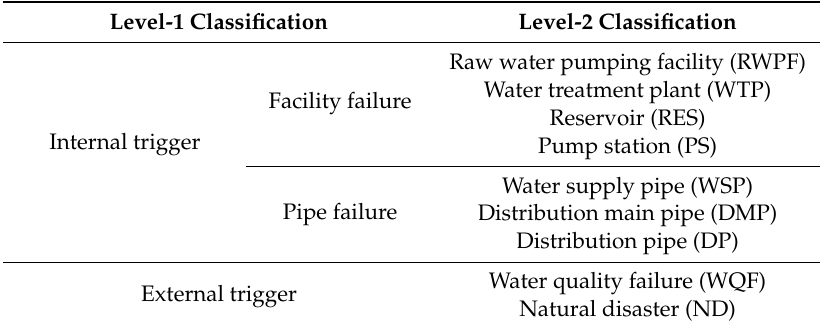
Table 1. WSDS failure classification system proposed in this